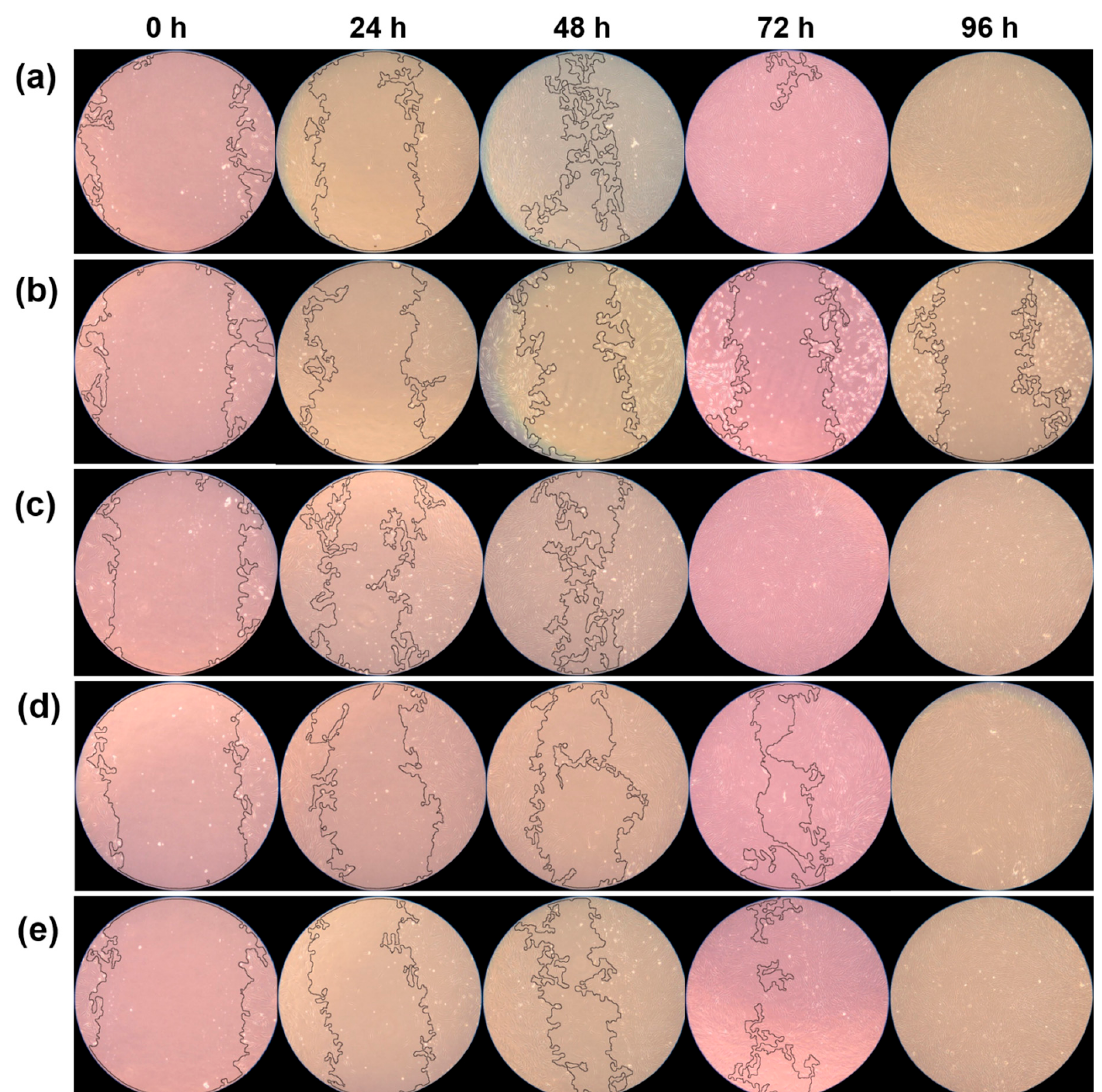
Figure 4. Representative image of wound healing percentage based on the cell migration assay. ( a ) Control group, ( b ) AH Plus group, ( c ) EndoSequence BC Sealer group, ( d ) BioRoot RCS group, ( e ) Endoseal MTA group.